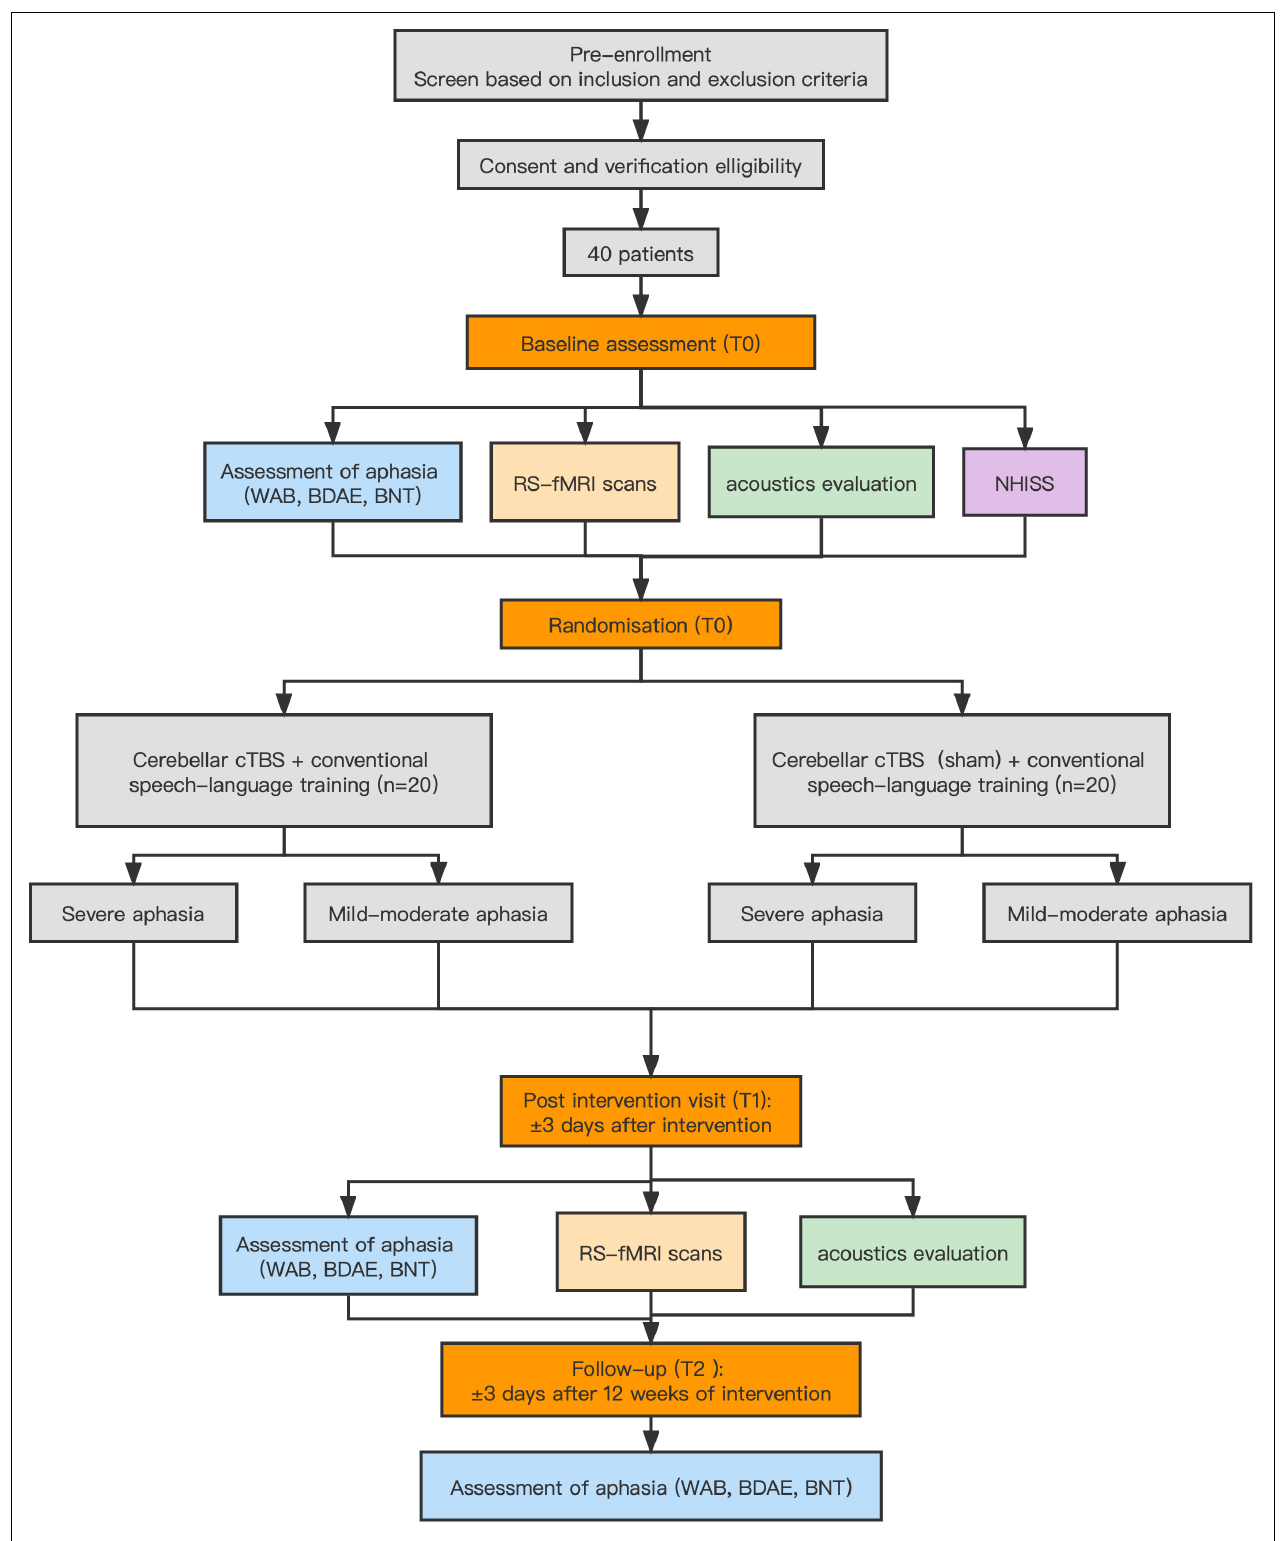
FIGURE 1 | Flow chart of study procedure. cTBS, continuous theta burst stimulation.